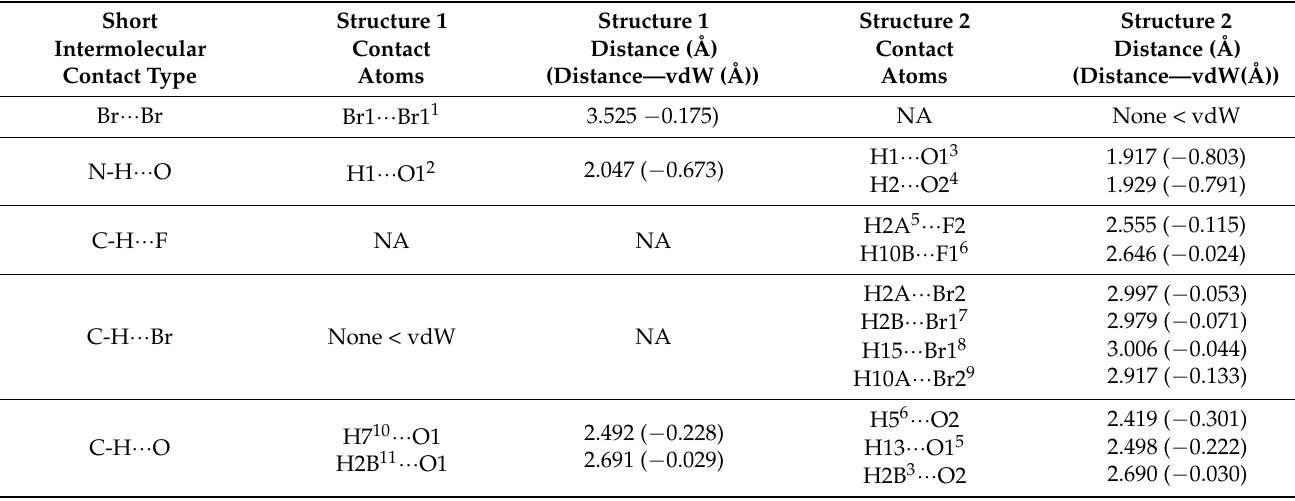
Table 2. Short Intermolecular Contacts in Structures 1 and 2 .